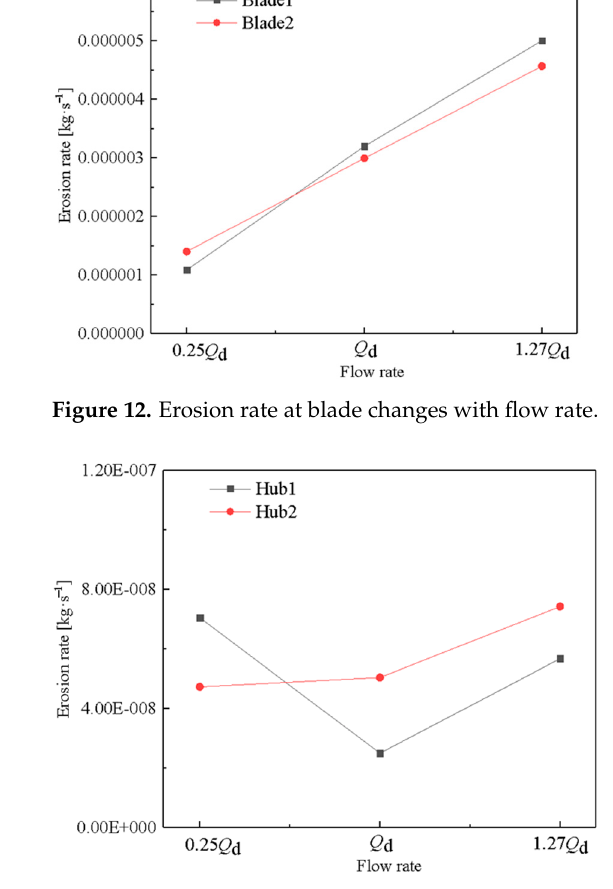
Figure 13. Erosion rate at hub changes with flow rate.